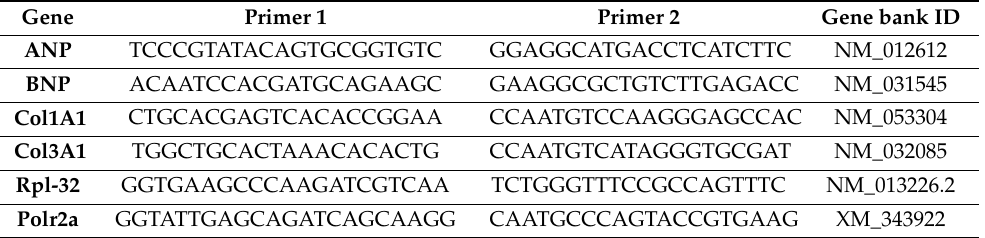
Figure 3. Development of cardiac function during 12 weeks of Sac/Val treatment. Systolic ( A ) and diastolic function ( B ) of lean, obese, and Sac/Val treated obese ZSF1 rats indicated by the LVEF and the ratio E/ é . Comparison of representative pulsed wave (PW) Doppler and Tissue Doppler sequences after 12 weeks of Sac/Val or sedentary life style ( C ). n = 15 (each, lean and obese) and n = 13–15 (Sac/Val). To test the effect of Sac/Val two-way one-way analysis of variance (ANOVA) with repeated measures followed by Bonferroni post hoc was used to compare echo data between the groups over time. * p < 0.05, ** p < 0.01, *** p < 0.001 vs. lean, respectively. ł p < 0.05, łłł p < 0.001 vs. obese. Table 3. List of primers for